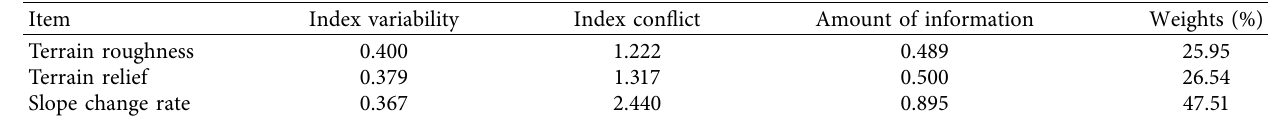
Table 7: CRITIC weight calculation